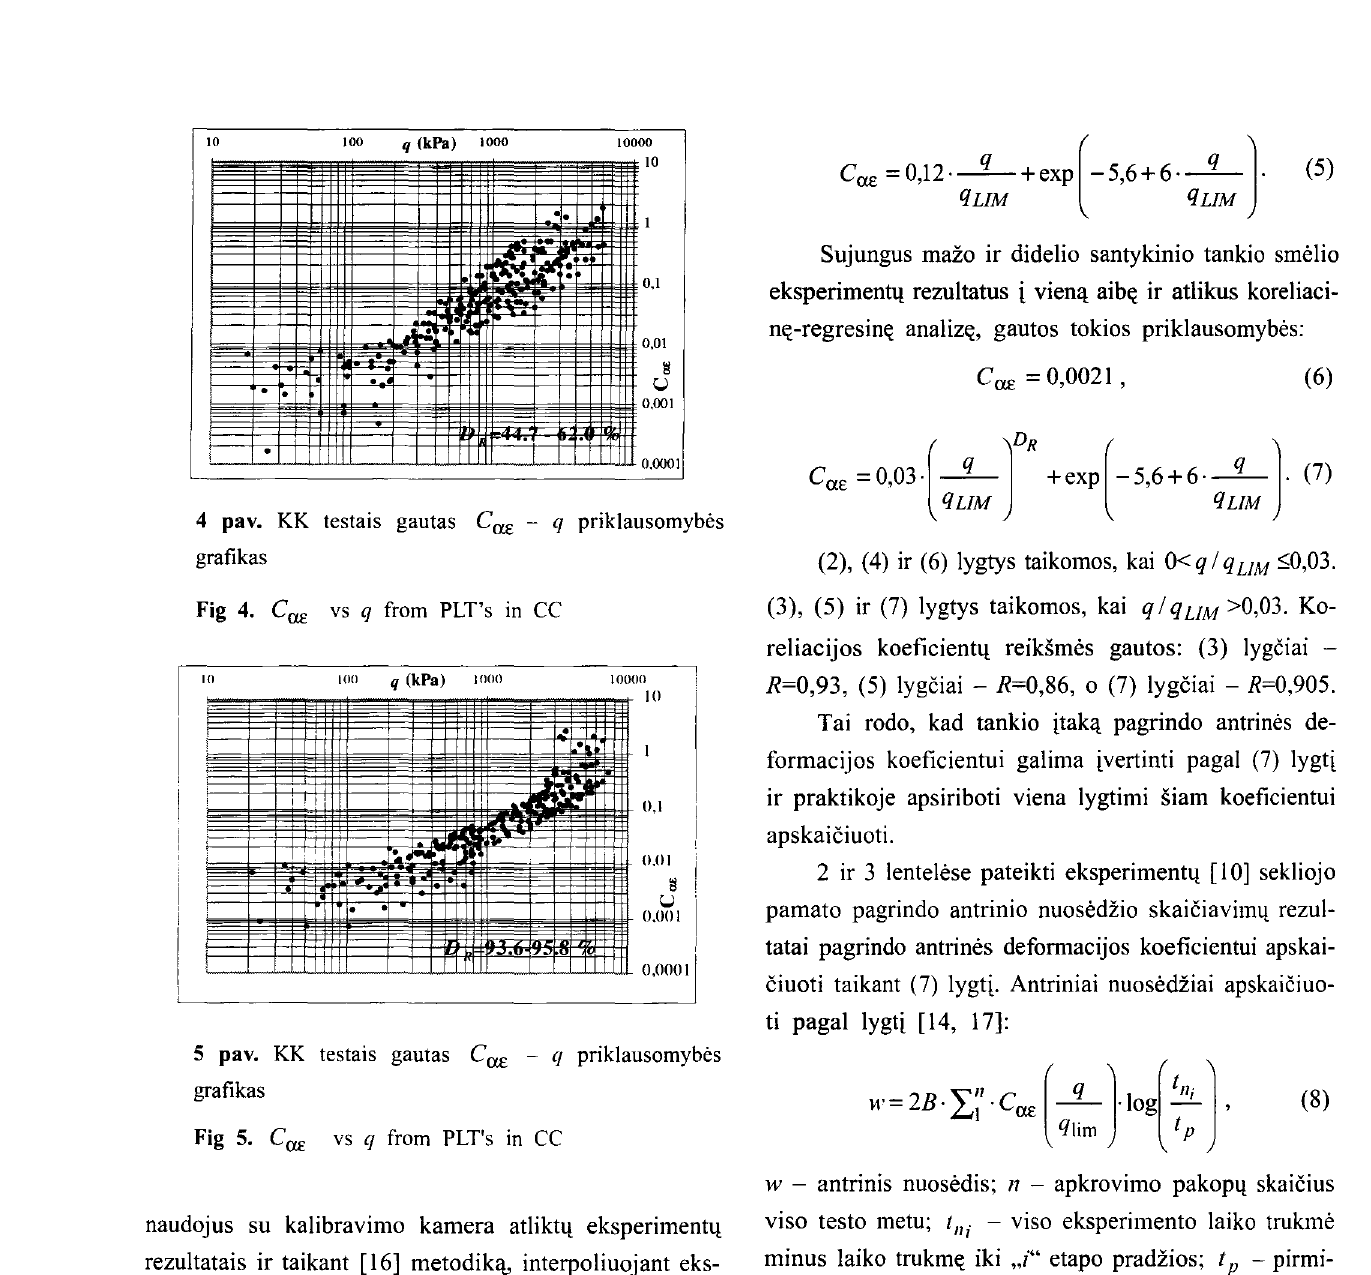
naudojus su kalibravimo kamera atlikt4 eksperiment4 rezultatais ir taikant [16] metodiklt, interpoliuojant